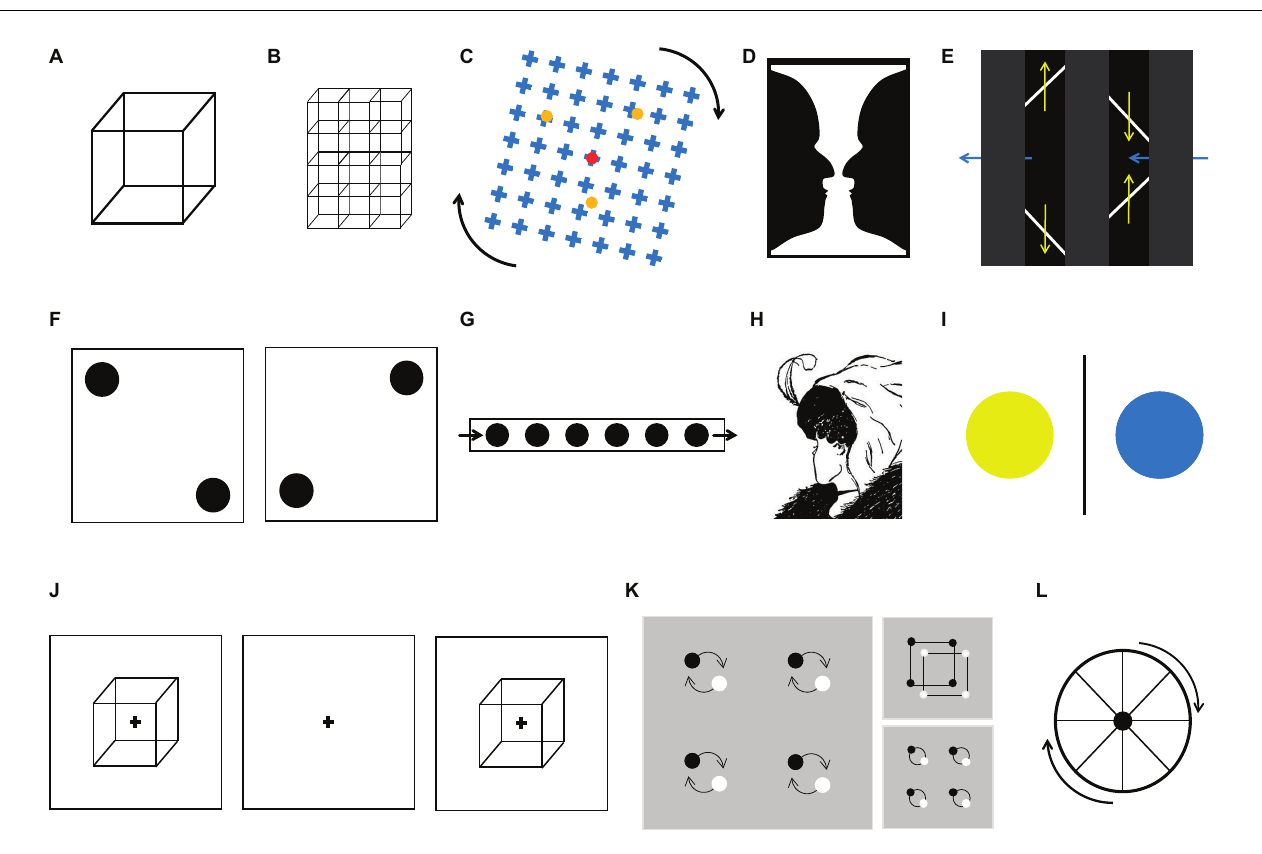
FIGURE 1 | Examples of ambiguous figures. (A) Necker cube. (B) Array or lattice of Necker cubes. (C) Motion induced blindness. (D) Rubin vase. (E) The diamond-lines illusion. (F) Basar dots. (G) Moving-dots illusion. (H) The lady and old woman illusion. (I) Binocular rivalry stimuli. (J) Discontinuous presentation method. Here, the bi-stable image was presented (usually for less than a second), followed by a delay, then the presentation of a stable version of the stimulus. The subject’s task was to report if the perception of the second image was the same as that for the first. Trials were classified as perceptual stability or perceptual changes. (K) Local vs. global percept illusion. (L) Wagon wheel